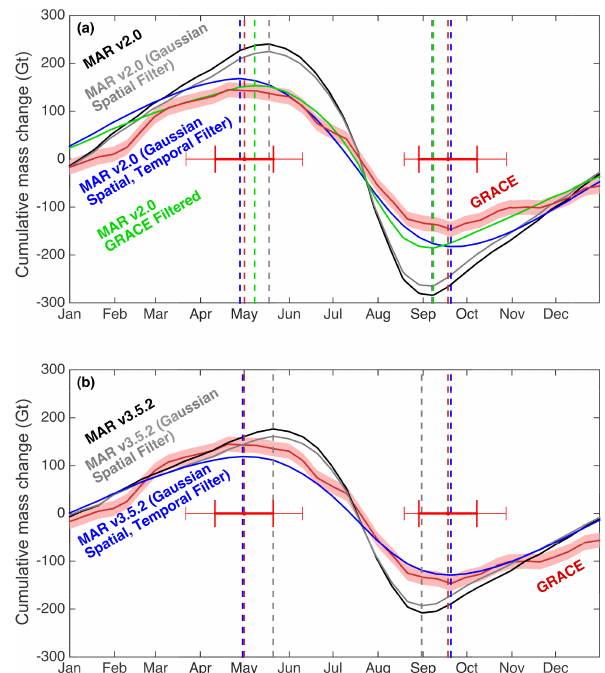
Figure 5. Average seasonal cycle of January 2003–December 2010 GrIS-wide detrended cumulative mass change (a) for GRACE-LM, unfiltered MAR v2.0 data, GRACE-LM-filtered MAR v2.0 data, and Gaussian-filtered MAR v2.0 data (with spatial filtering and spa- tial + temporal filtering). (b) The same as (a) , for MAR v3.5.2 (for which GRACE-LM-filtered data are not available). Vertical dashed lines indicate the timing of peaks of maximum and minimum mass in the cycle. Red horizontal error bars indicate the error in the timing of the GRACE cycle. Bold error bars indicate 50% of the GRACE- LM distribution, and thin red lines indicate 95% of the distribution. The error bars have been extended for 10 days in either direction to account for errors associated with temporal